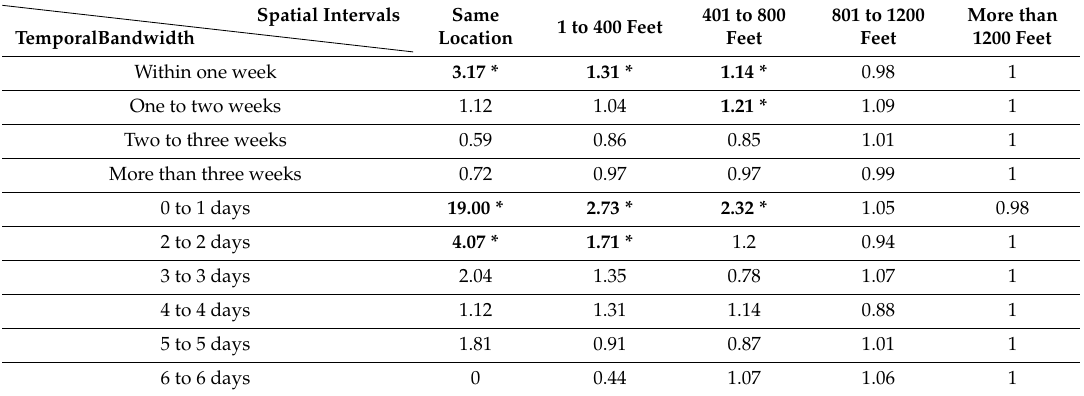
Table 3. Observed gunshots over mean expected frequencies using spatiotemporal bandwidths. TemporalBandwidth